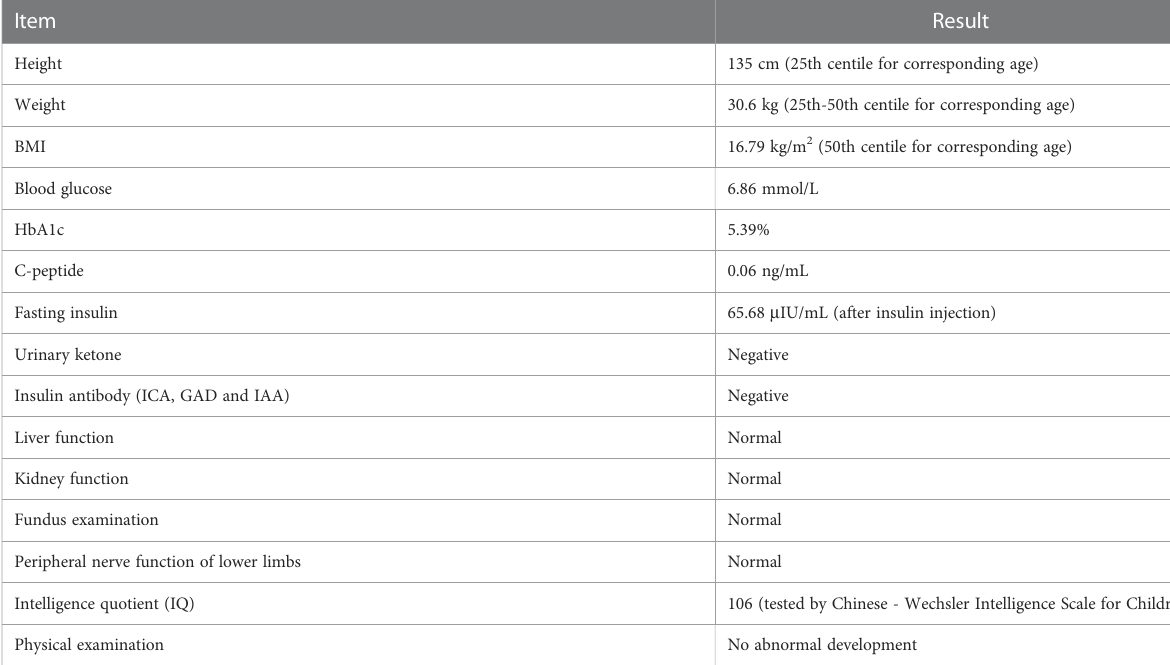
TABLE 1 Detailed examination results of the patient in his ten years old (2021.11.01).